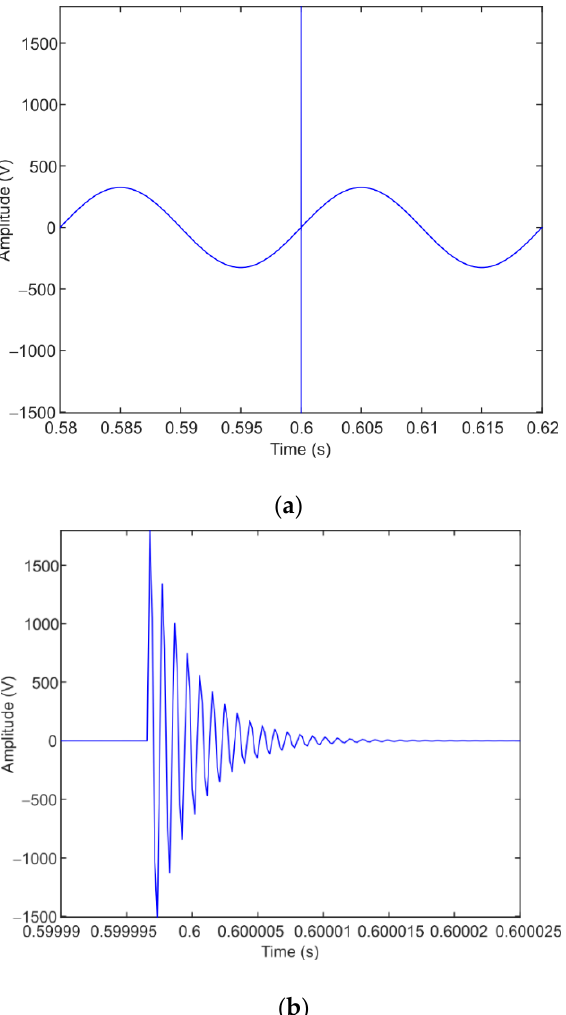
Figure 9. Model of fast transient disturbance with frequency oscillation of 1 MHz: ( a ) power signal and ( b ) expanded disturbance.